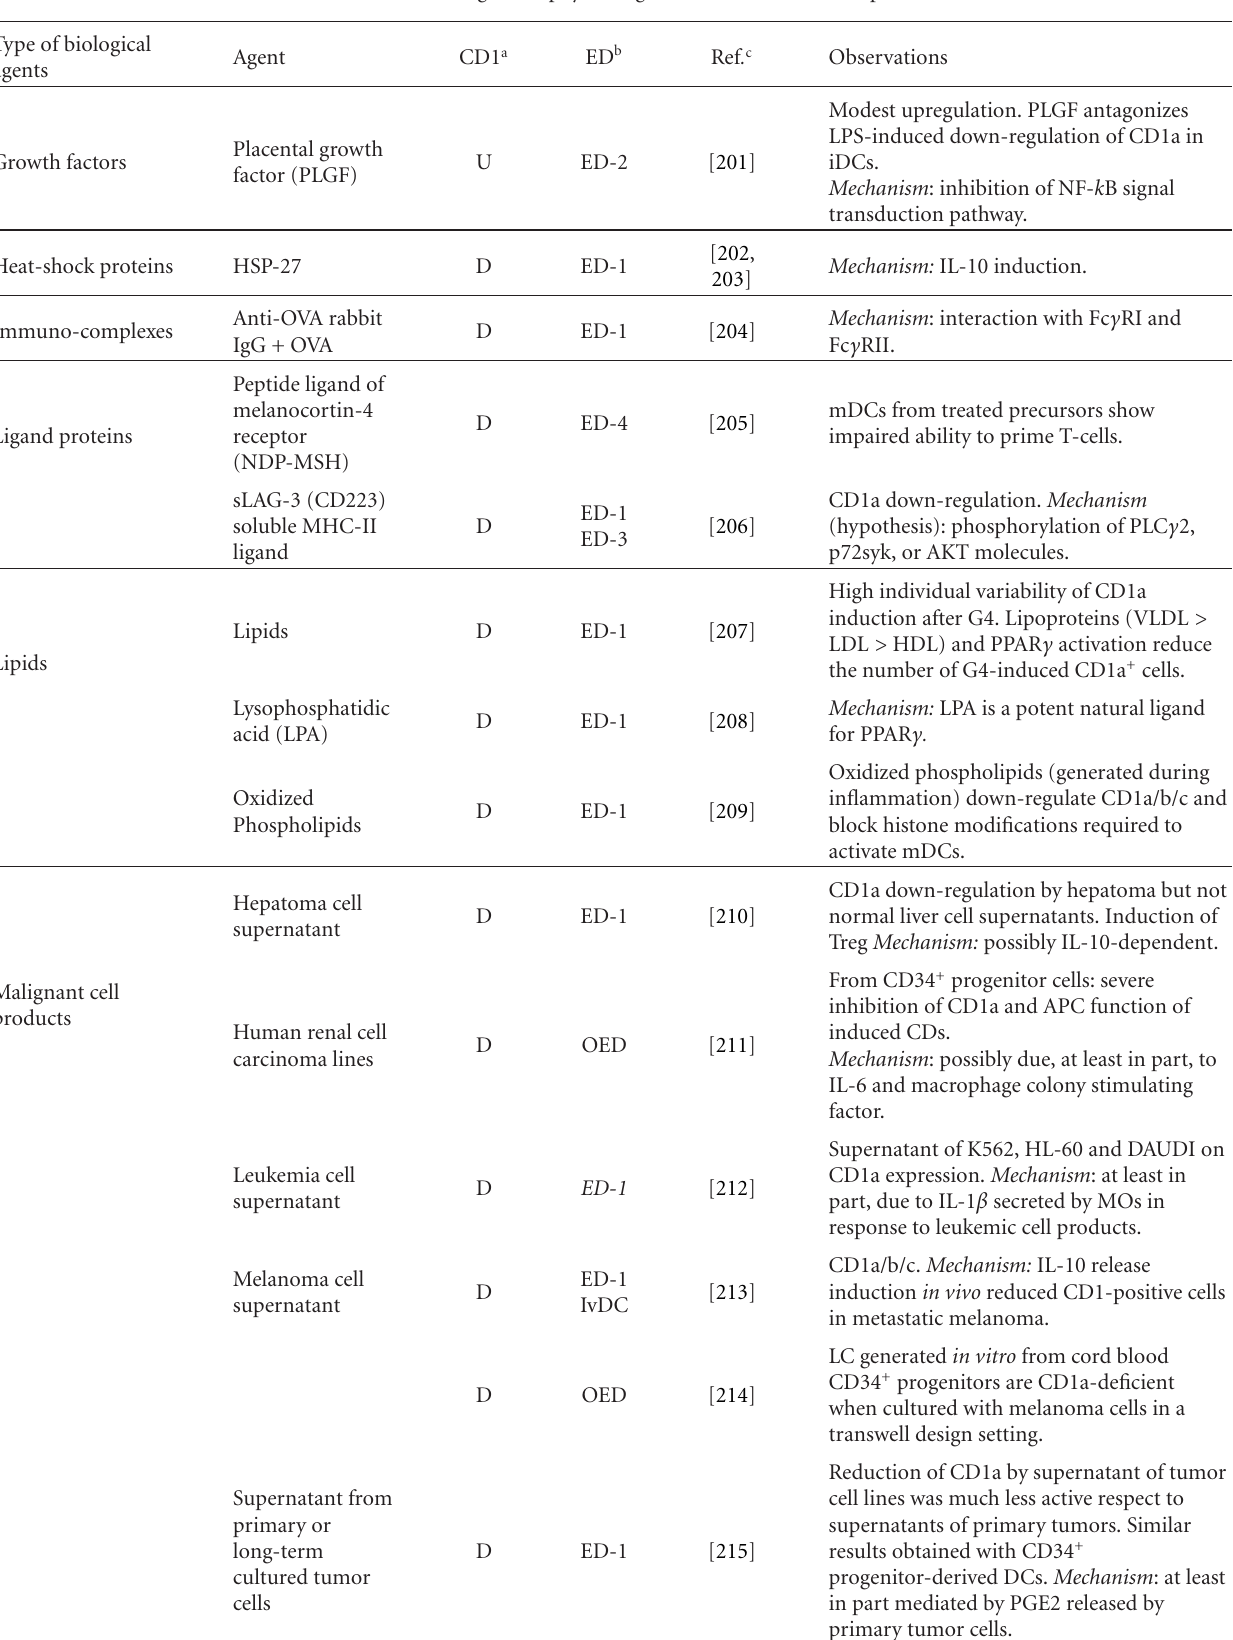
Table 4: E ff ect of biological or physical agents on CD1 molecule